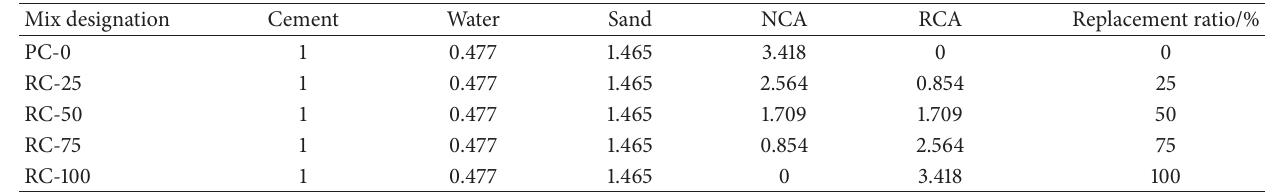
Table 1: The mix proportions of RAC test specimens.